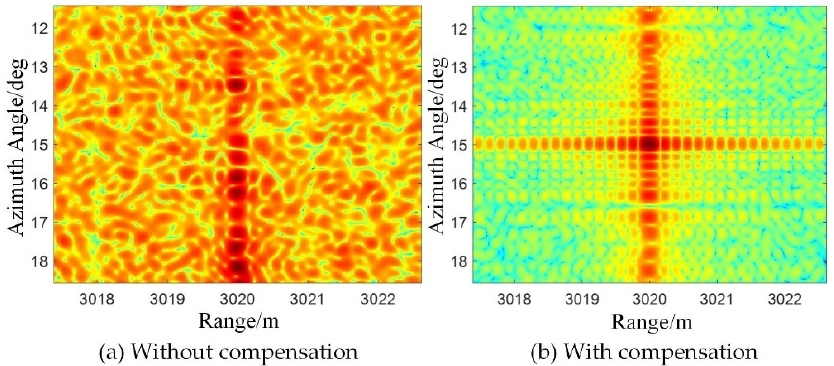
Figure 5. BP image result after conventional calibration ( a ) without compensation ( b ) with compensation.